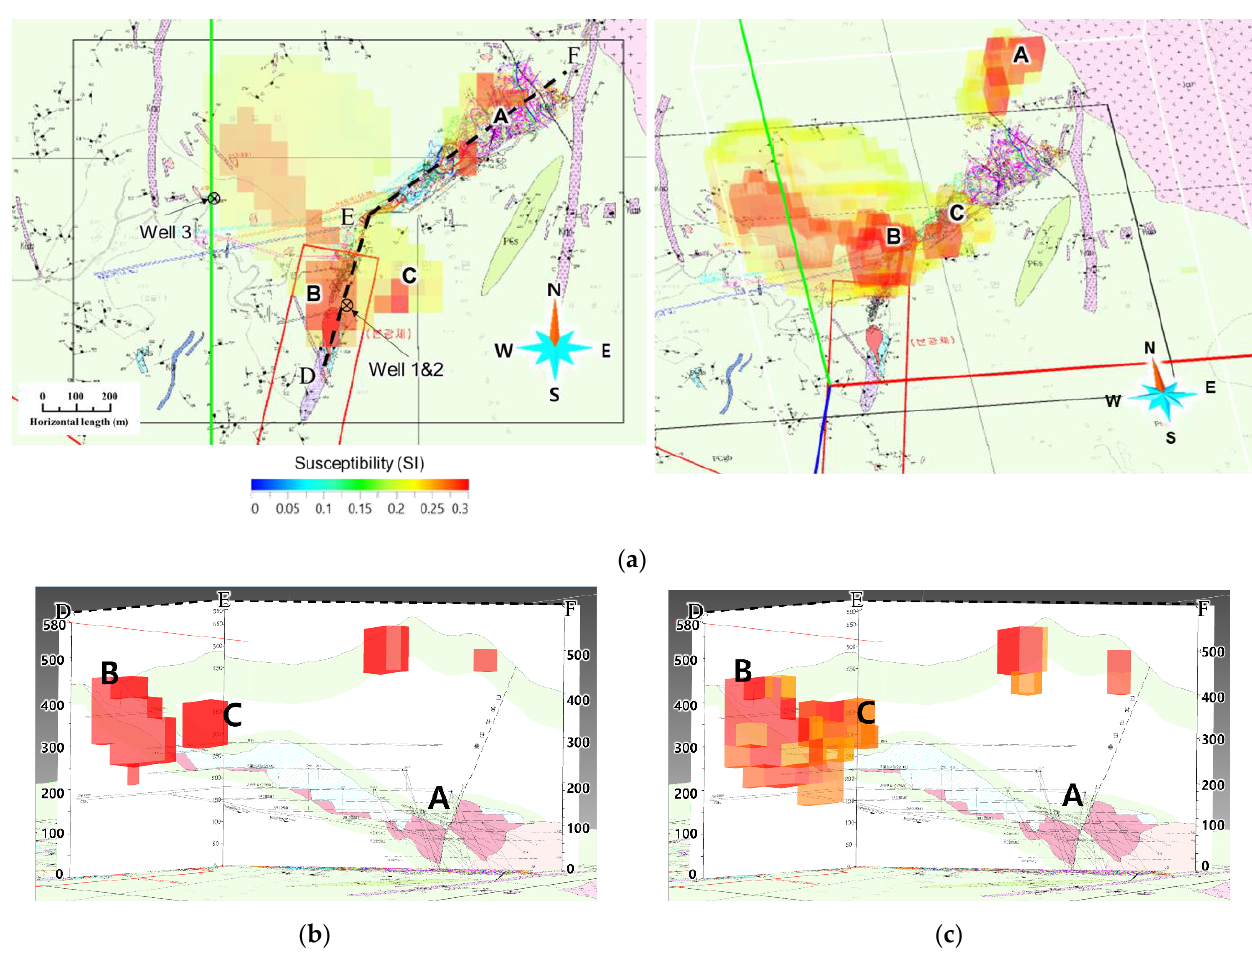
Figure 7. Inversion results of aeromagnetic data acquired using the multicopter system shown in Figure 5: ( a ) plan view showing only areas with a susceptibility greater than 0.2, ( b ) side view showing only areas with a susceptibility greater than 0.28, and ( c ) side view showing only areas with a susceptibility greater than 0.25. The location of geological cross section shown in Figure 7b,c is indicated by dashed lines DE and EF in Figure 7a. The cross section shows the predicted distribution of potential iron ore (pink region) based on the position information of iron ore confirmed through drilling in the mine and the region developed so far.